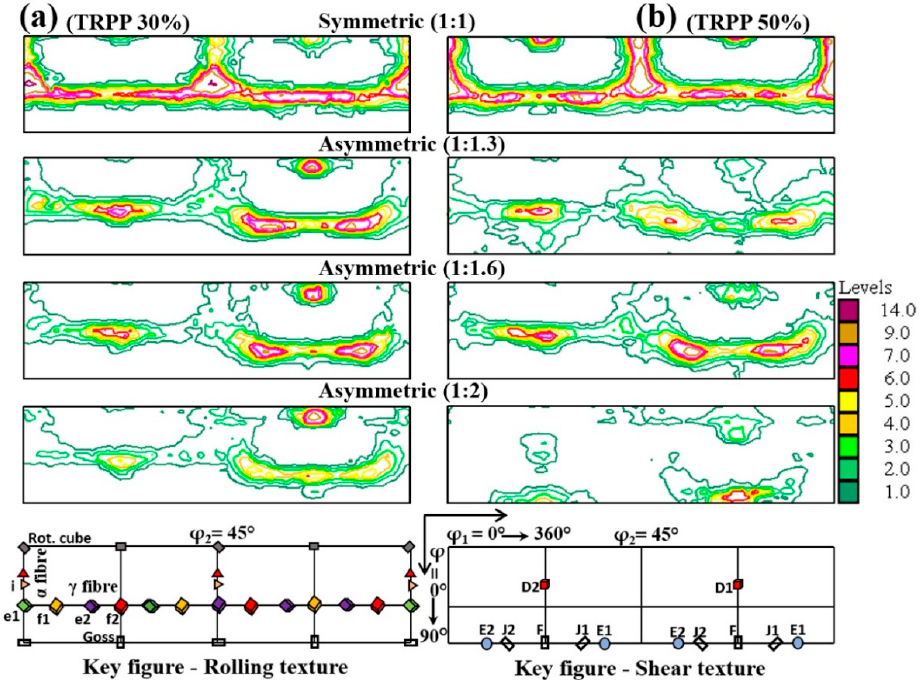
Figure 5. φ 2 = 45° ODF sections in high strain range (89%) for symmetric and asymmetric rolling with TRPP of ( a ) 30% and ( b ) 50% for varying roll diameter ratios from 1:1 to 1:2.